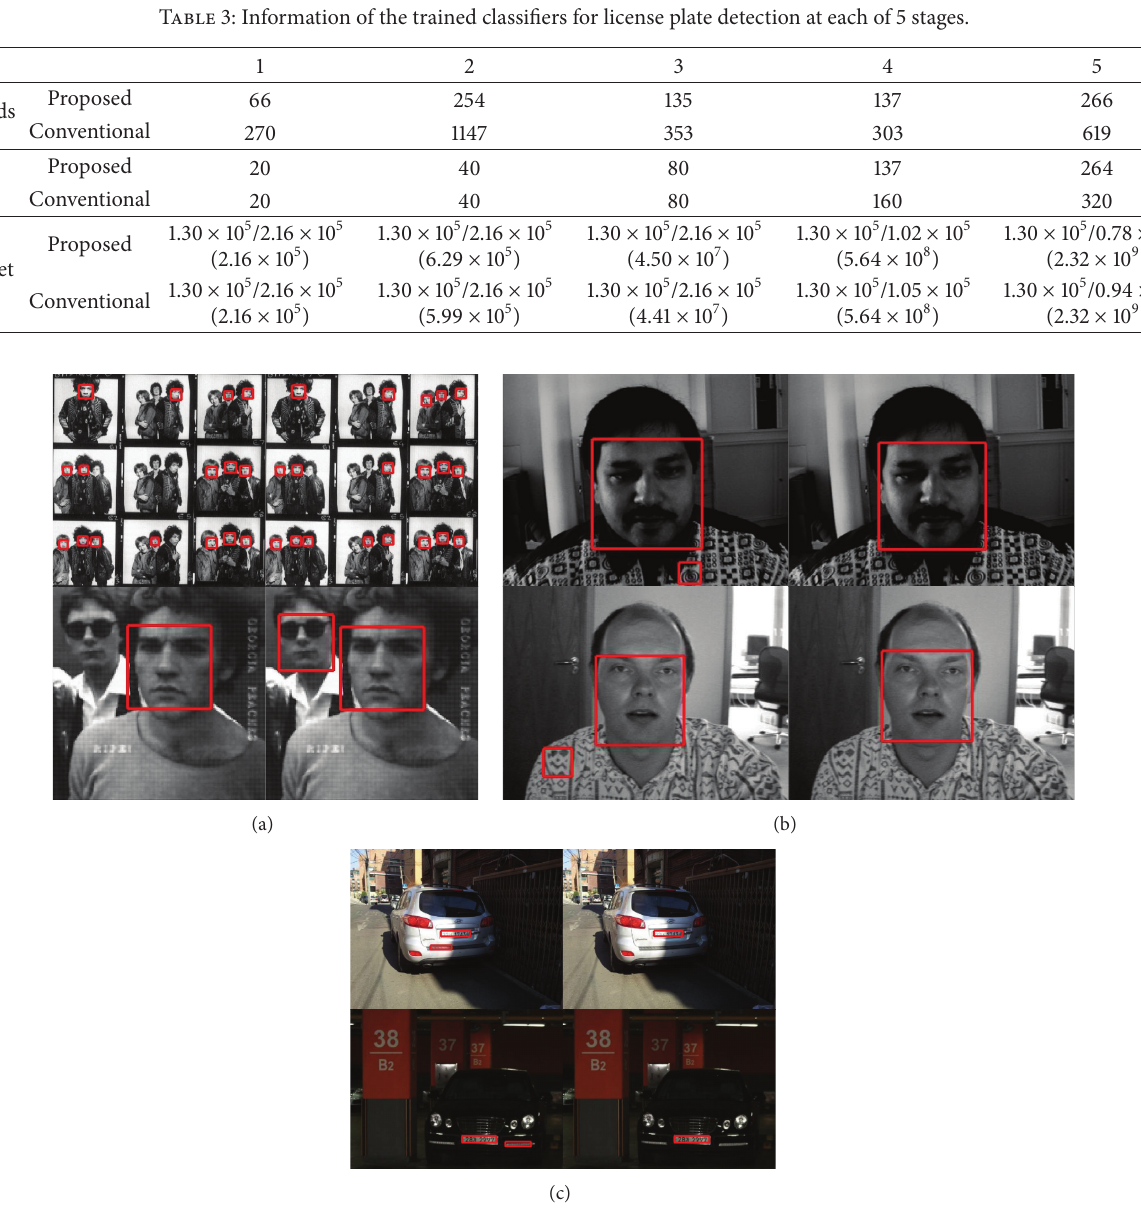
Figure 12: (a) Examples of detection results for MIT + CMU DB. (b) Examples of detection results for BioID DB. (c) Examples of detection results for license plate